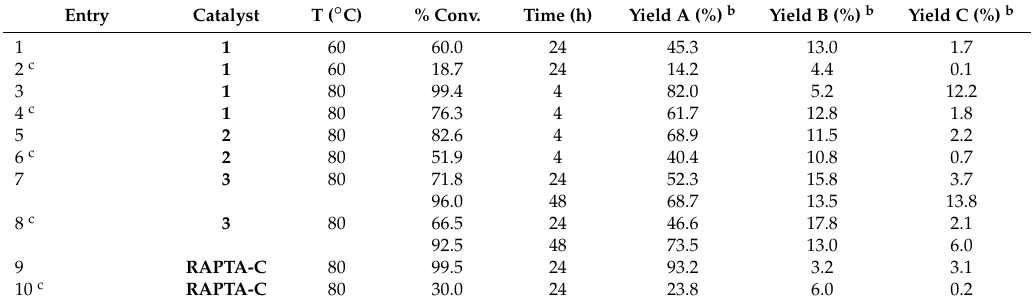
Table 1. Catalytic transfer hydrogenation of benzylidene acetone (BZA) with complexes 1 – 3 a